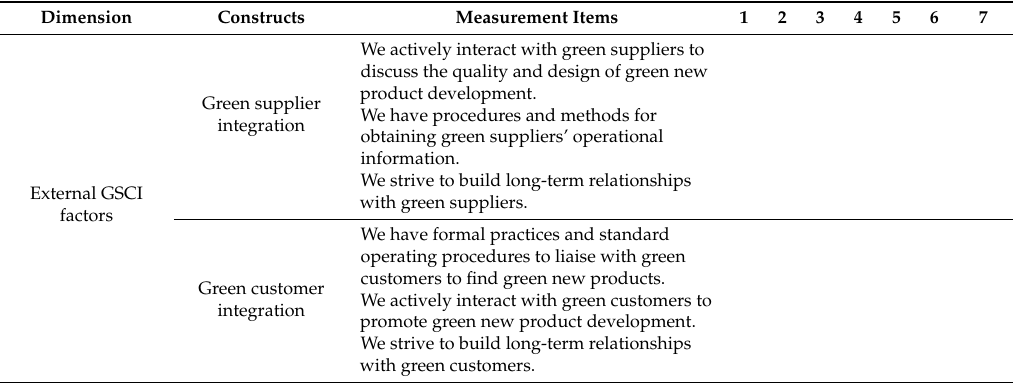
Table A1. Questionnaire used in the